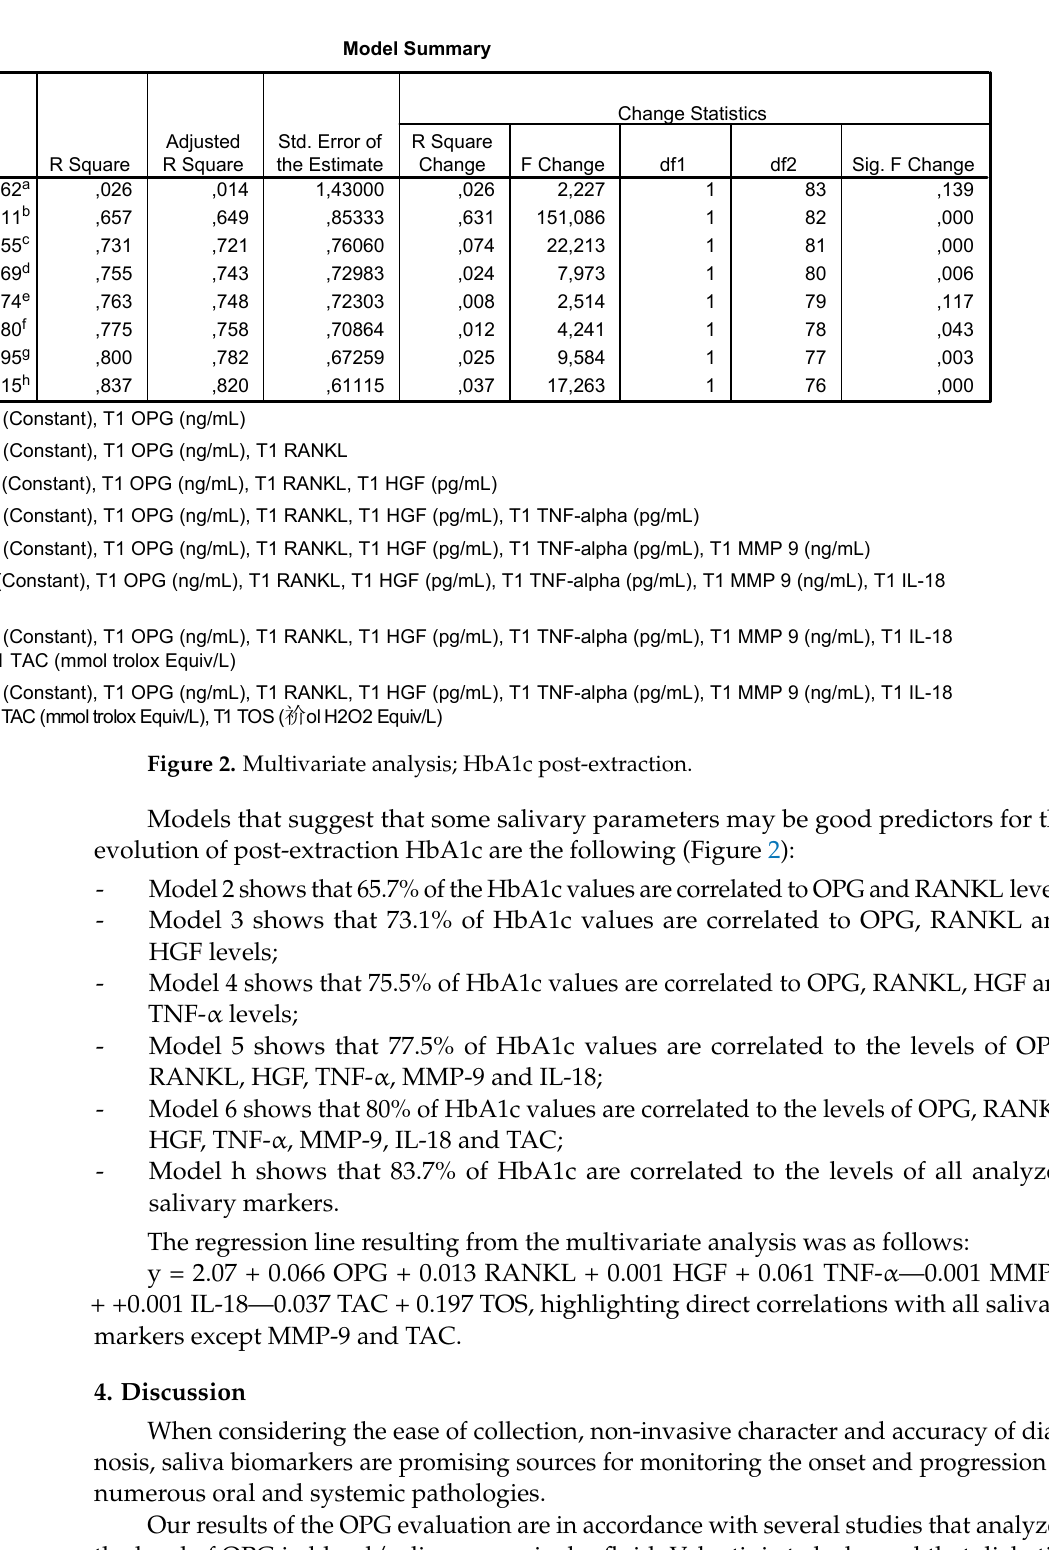
8 of 14 Figure 1. Post ‐ extraction correlation of HbA1c with salivary markers (OPG, RANKL, OPG/RANKL, HGF, TNF ‐α , MMP ‐ 9, IL ‐ 18, TOS and TAC). We used multivariate analysis to quantify the intensity and direction of influence of the correlation between the analyzed factors (Figure 2). Multiple linear regression estab ‐ lishes the predictive efficiency of detected salivary markers (independent variables) on the HbA1c dependent variable post ‐ extraction. Models that suggest that some salivary parameters may be good predictors for the evolution of post ‐ extraction HbA1c are the following (Figure 2): ‐